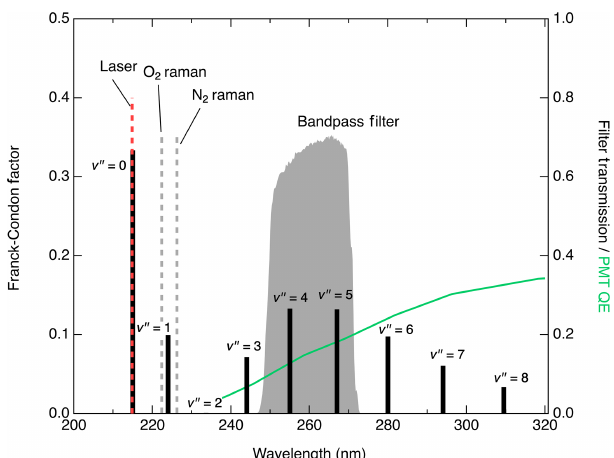
Figure 4. Franck–Condon factors (black sticks plotted on left axis) indicating the expected distribution of the fluorescence inten- sity from the A 2 (cid:54)(v (cid:48) = 1 ) → X 2 (cid:53) relaxation. Grey shaded region (right axis) shows detected spectral region in this work. Locations of significant scatter from Rayleigh, O 2 Raman, and N 2 Raman are also indicated. Green line plotted against the right axis shows the quantum efficiency (QE) of the PMT module used in this